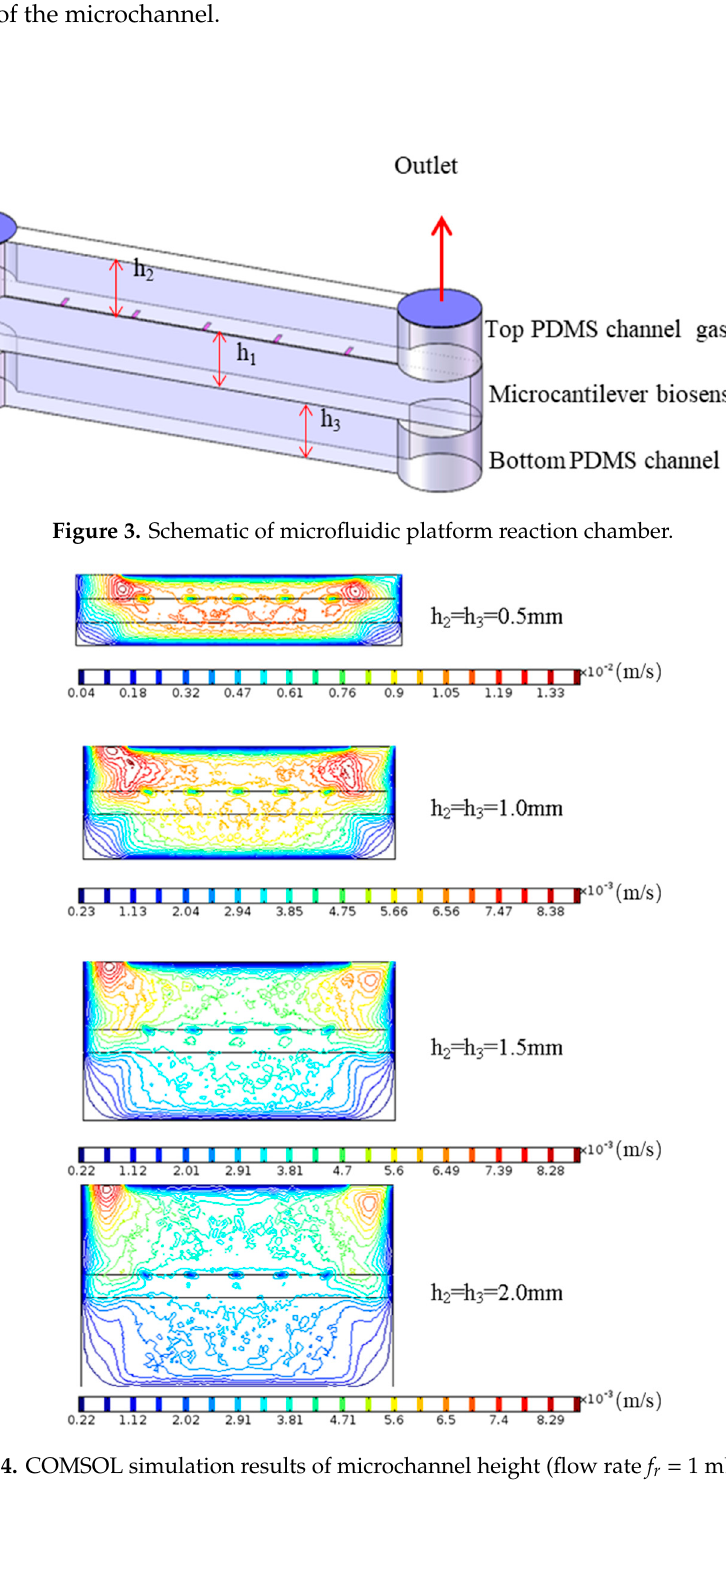
Figure 5. The microfluidic system. 3.1. Verifying the Effect of the Secondary Antibody by Fluorescently Labeled F1 Antigen The fluorescently labeled F1 antigen was detected to verify whether the secondary antibody could increase the capture efficiency. Figure 6 depicts fluorescence microscope pictures with and without modifying the secondary antibody (1 μ g/ml) to the surface of the cantilever prior to locally immobilizing the F1 antibody (1 μ g/ml). The sensor with the secondary antibody modification